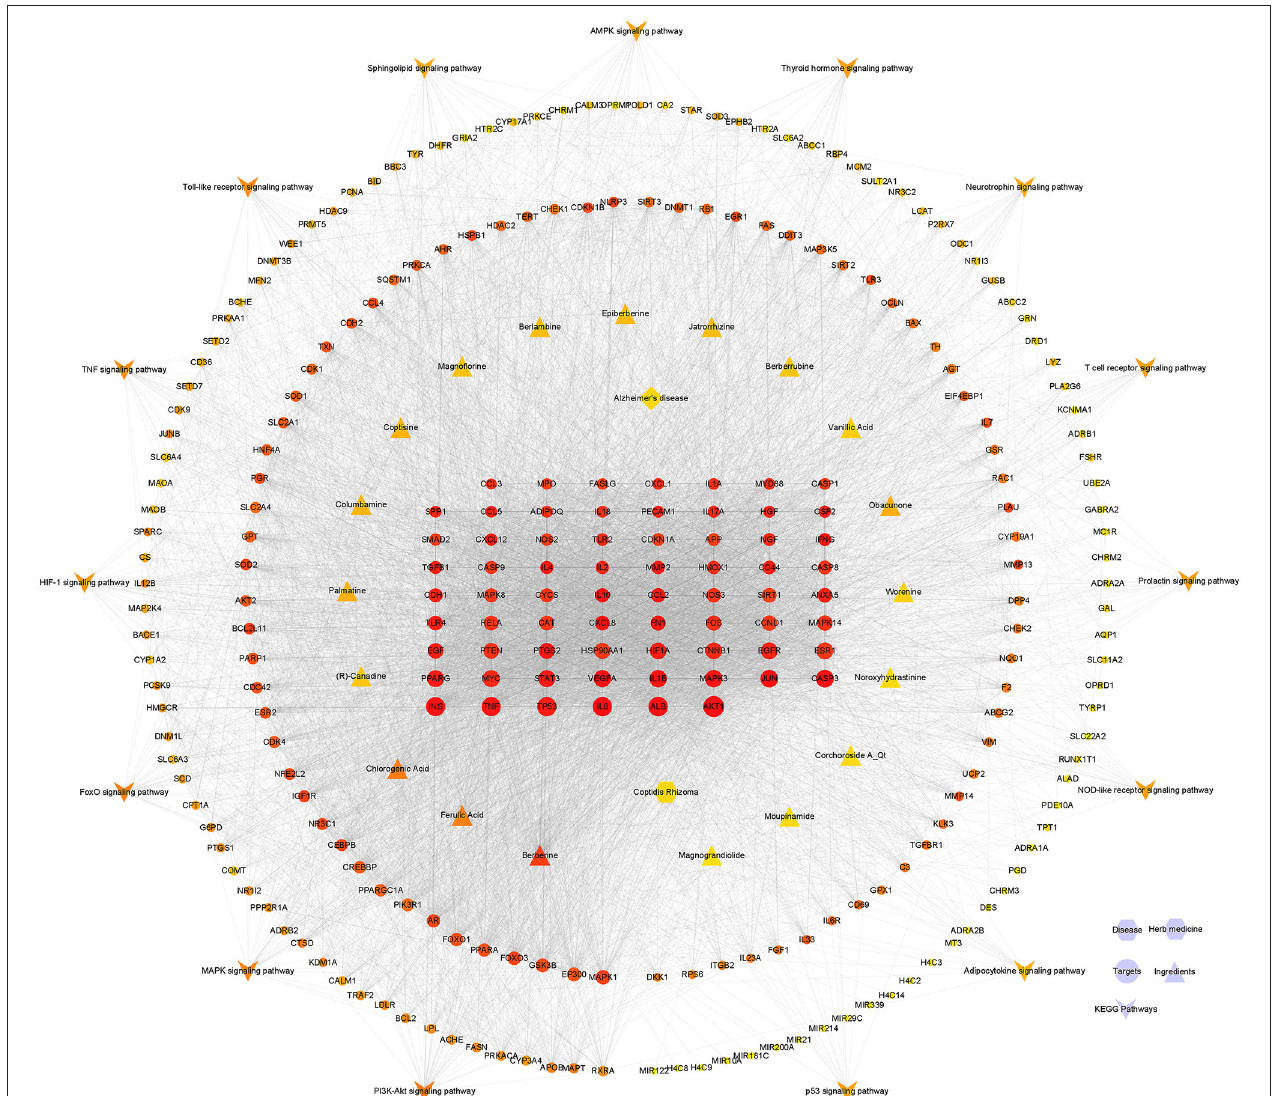
FIGURE 8 | The “component-target-pathway” network